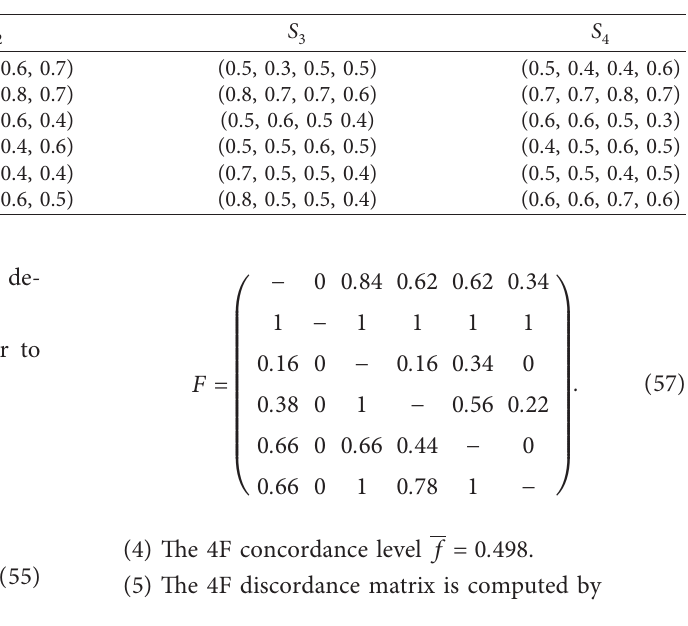
Table 2: 4F decision